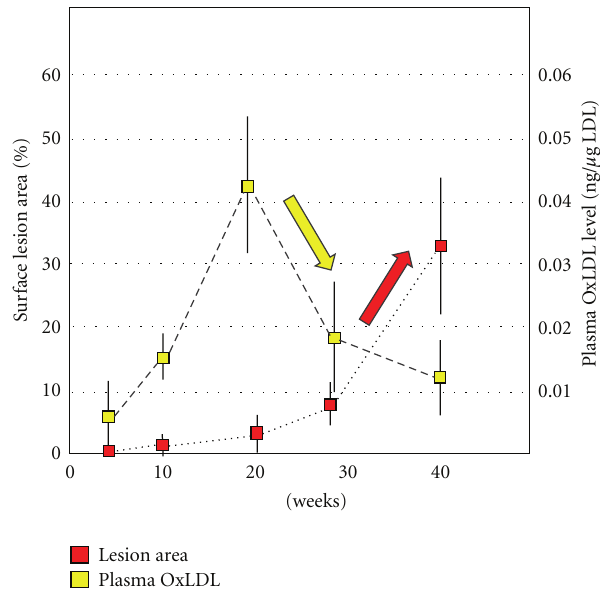
Figure 1: Temporal changes in plasma OxLDL levels and athero- genesis in apoE-KO mice. Male apoE-KO mice were maintained on normal diet up to 40 weeks. The atherosclerotic lesion on the aortic surface increased sharply after 20 weeks. Plasma OxLDL levels increased at 20 weeks just before the lesions began growing. The plasma OxLDL levels seem to decrease concomitantly with an increase in the size of the lesion (cited from [41] with